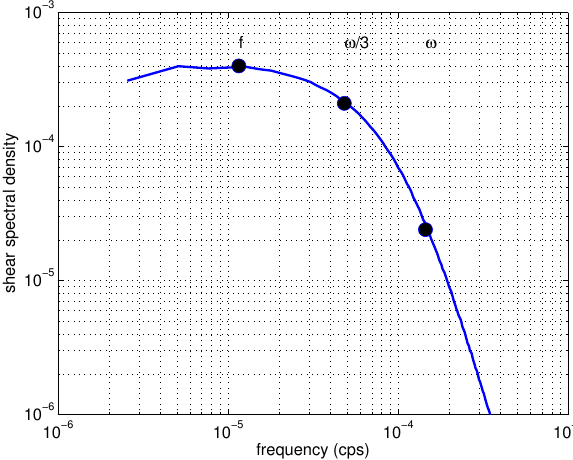
Figure 5. Example of a frequency spectrum of vertical shear following a ray path for a background with e o / e GM = 1 × 10 − 2 . These frequency spectra are band-width limited and white. Note that the vertical wavenumber spectrum is white and the bandwidth inferred from the frequency spectrum leads to a short decorrelation time scale, approximately 1/2 a wave